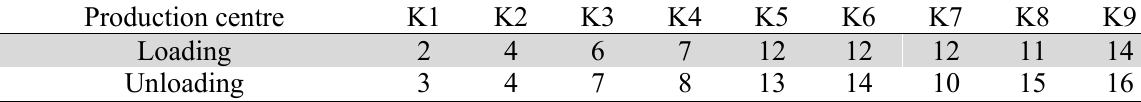
Loading - Unloading distance matrix between the production centers Production centre